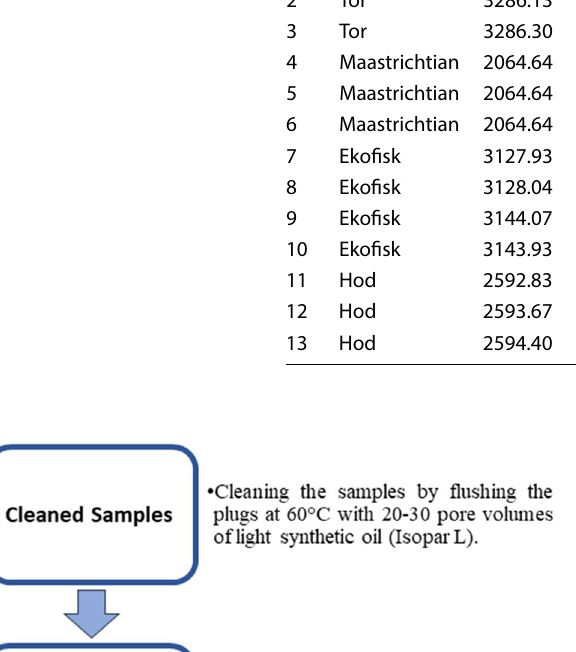
Table 1 Measured and calculated wettability indices of chalk samples from selected North Sea fields [38]